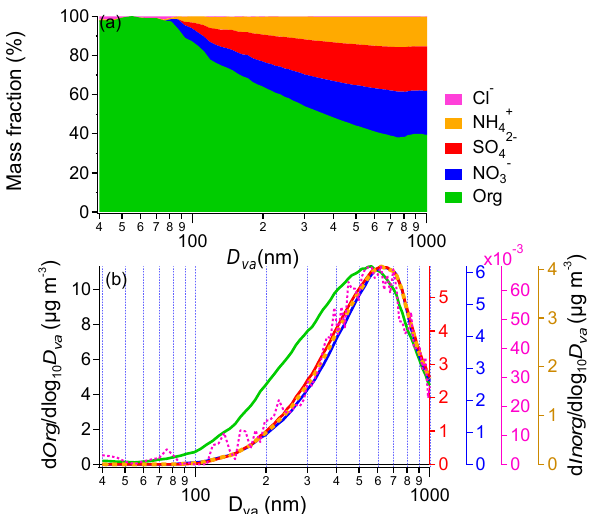
Figure 6. (a) Averaged mass fractional contributions of each NR- PM 1 species to the total NR-PM 1 mass as a function of size; (b) campaign-averaged size distributions for individual NR-PM 1